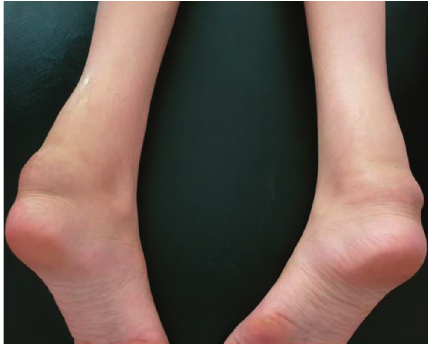
Figure 1: Bilateral and symmetrical hypertrophy of Achilles